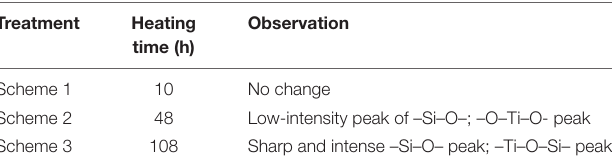
TABLE 2 | Treatment of NPs of TiO 2 (1.5 g) with APTES (1.5 ml) in xylene as a medium (50 ml) at 50 ◦ C for various durations and the chemical changes confirmed from FTIR